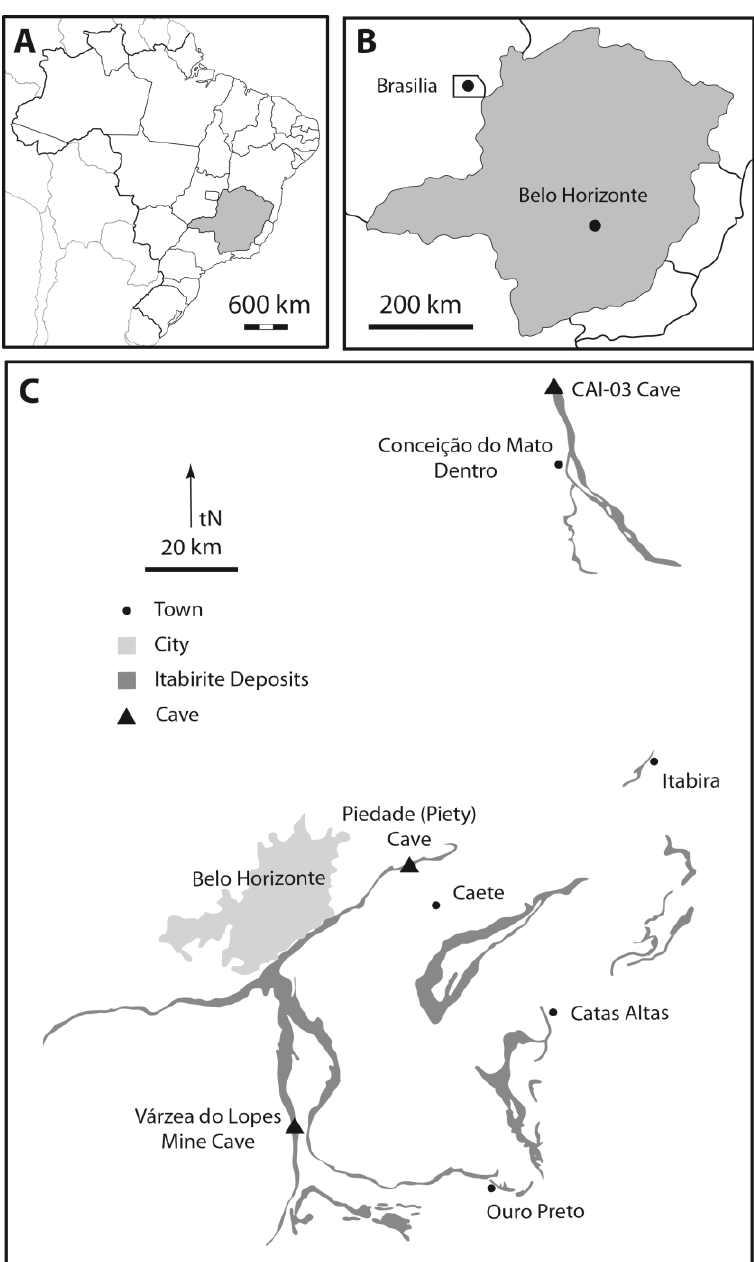
Figure 5. Map showing locations of caves and sampling locations from this study. Map of Brazil ( A ) with Minas Gerais shaded. Panel ( B ) illustrates location of Belo Horizonte. And panel ( C ) illustrates sampling locations and itabirite deposits in relation to Belo